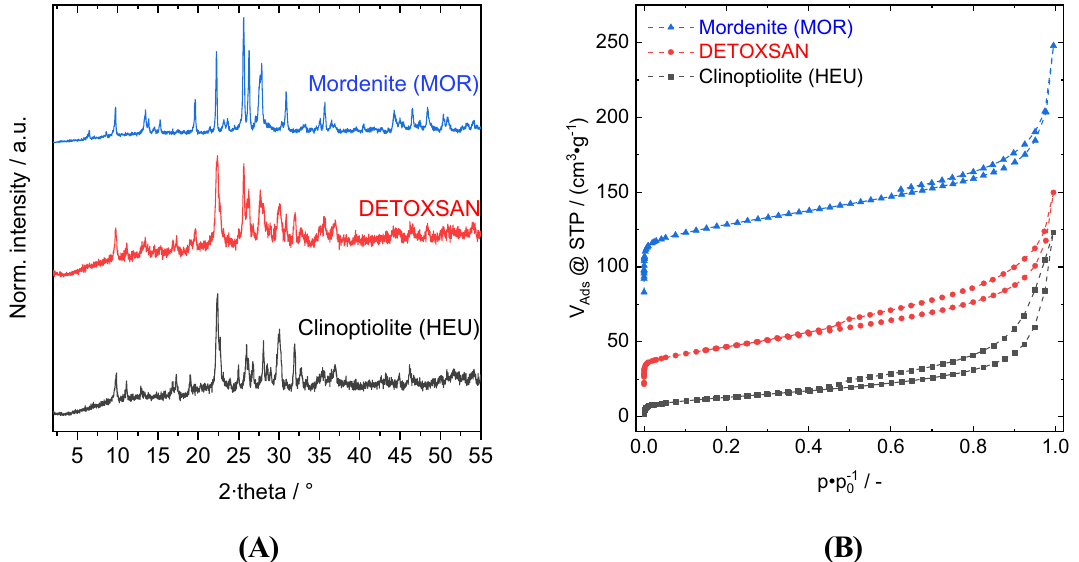
Figure 1. X-ray diffraction patterns ( A ) and nitrogen physisorption isotherms ( B ) for mordenite, clinoptilolite, and DETOXSAN, a mixture of 43% HEU and 35% MOR. ( A ) Shows the normalized intensity (norm. intensity) of the X-ray beam in dependence of the diffraction angel (2 theta). ( B ) Shows the adsorbed nitrogen volume at standard temperature and pressure (V ads @STP) as a function of the relative pressure (p p 0 −1